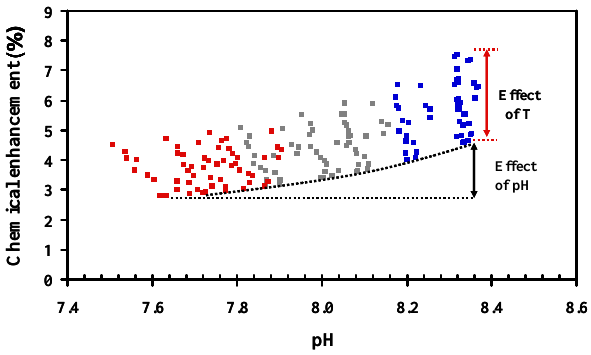
Fig. 4. Chemical enhancement of CO 2 compared to N 2 O according Chemical enhancement of CO 2 compared to N 2 O according to Hover and Berkshire (1969) 855 to Hover and Berkshire (1969) calculated for measured k , S , T and calculated for measured k , S, T and pH tot during the Svalbard experiment. High CO 2 856 pH tot during the Svalbard experiment. High CO 2 treatments are treatments are red, medium are gray and low CO 2 are blue. The effect of pH tot on chemical 857 red, medium are gray and low CO 2 are blue. The effect of pH tot enhancement is indicated by the black arrow, while the effect of the ~3°C temperature 858 on chemical enhancement is indicated by the black arrow, while the increase during the experiment is indicated by the red arrow. 859 effect of the ∼ 3 ◦ C temperature increase during the experiment is indicated by the red